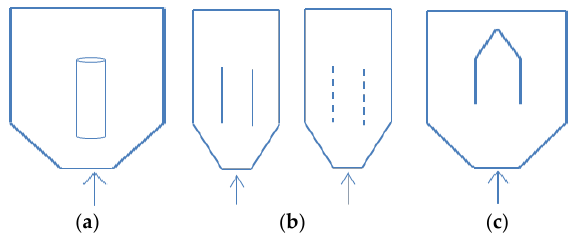
Figure 8. Scheme of possible auxiliary devices used with SB: porous/non-porous draft tubes ( a ); porous/non-porous draft plates ( b ) or the recently proposed fountain confiners ( c ).